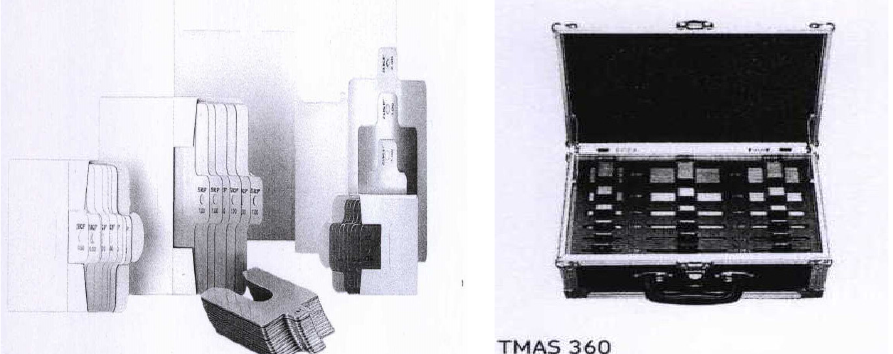
Figure 8 – Set of special metal plates for multiplier